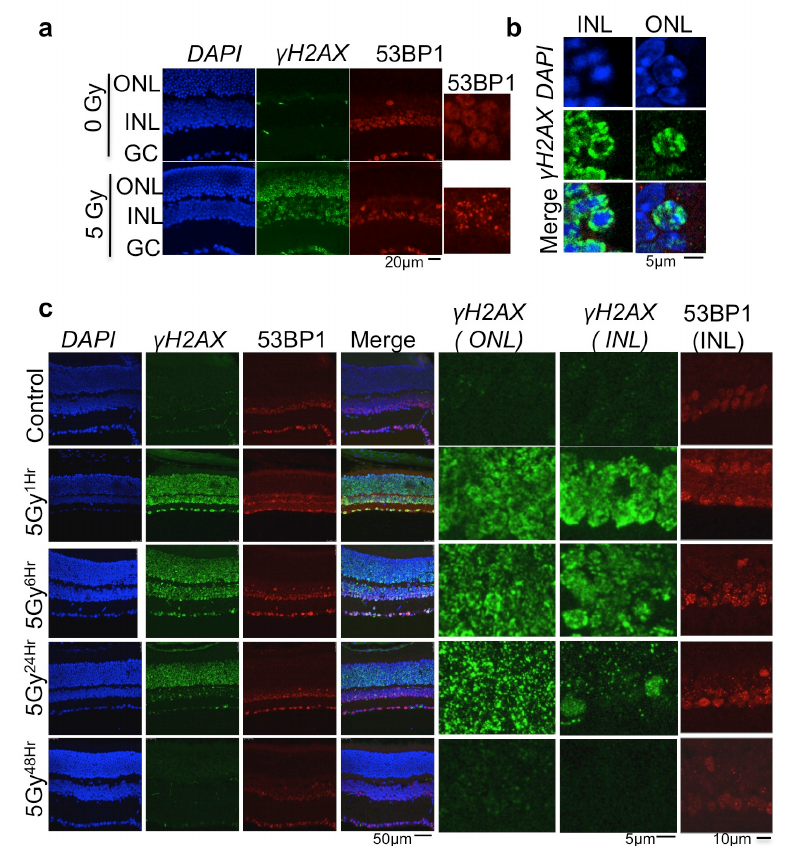
Figure 3. DNA repair response to irradiation-induced DNA-breaks in adult mice retina. ( a ) Immunofluorescence performed using anti- γ H2AX and 53BP1 antibodies in mice retina 1hr after exposure to 5 Gyrase of ionizing radiation. γ H2AX appears in all cell types in response to DNA breaks. 53BP only observed in the ganglion cell layer (GC) and inner strata of inner nuclear layer (INL) (see Figure 1a). Zoom in show foci formation in cells expressing 53BP1. ( b ) H2AX phosphorylation in all retinal cell types is euchromatin specific. ( c ) Kinetics of DNA repair in mice retina. Post-Irradiation, mice were sacrificed at indicated times and retinal sections were analysed for γ H2AX and 53BP1. Left panel show all nuclear layers of retina; right panel show zoom in images to emphasize foci formation. Two mice were used for each condition, which were processed and stained together. Random image were taken using confocal microscope on each